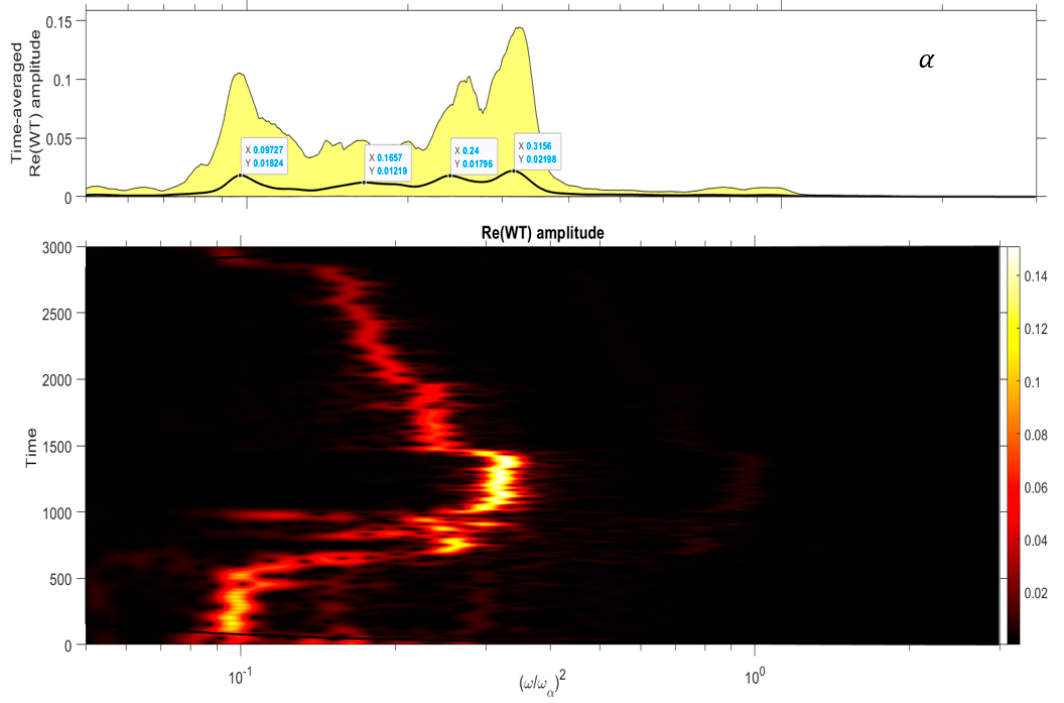
Figure 12. Time–frequency analysis: Pitch ( 𝑄 (cid:3042) = 15.6 ).